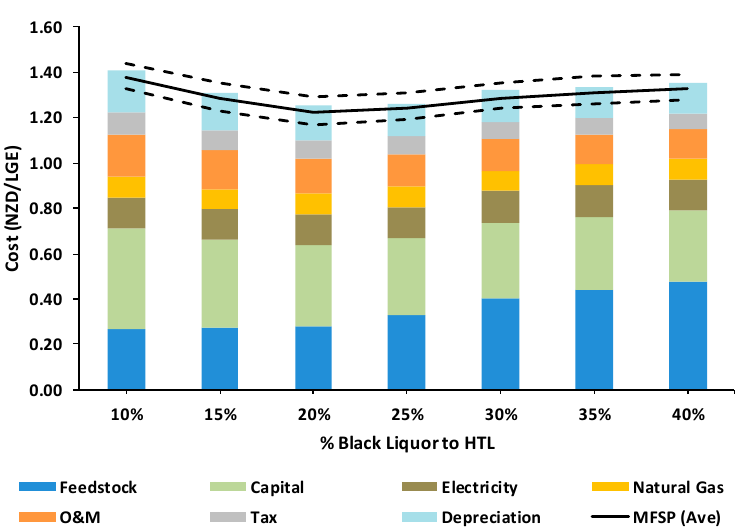
Figure 11. E ff ect of black liquor solids in HTL. Figure 11. Effect of black liquor solids in HTL.